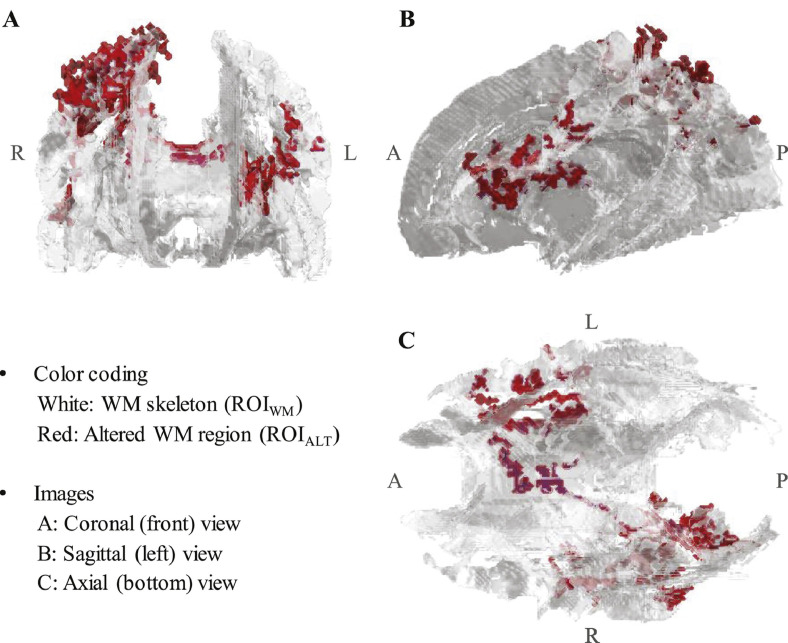
3D visualization (MATLAB) of ROIALT depicted on a fractional anisotropy-derived white matter skeleton, ROIWM. 3.96% (comprising 14 WM tracts) of the tested volume was found to exhibit significantly greater/lesser fractional anisotropy (FA) at one or more follow-up session (FBA: In1, In2, Post; NCA: Retest), relative to baseline (FBA: Pre; NCA: Test). White matter tracts in which ROIALT voxels were observed are listed in Table 5.